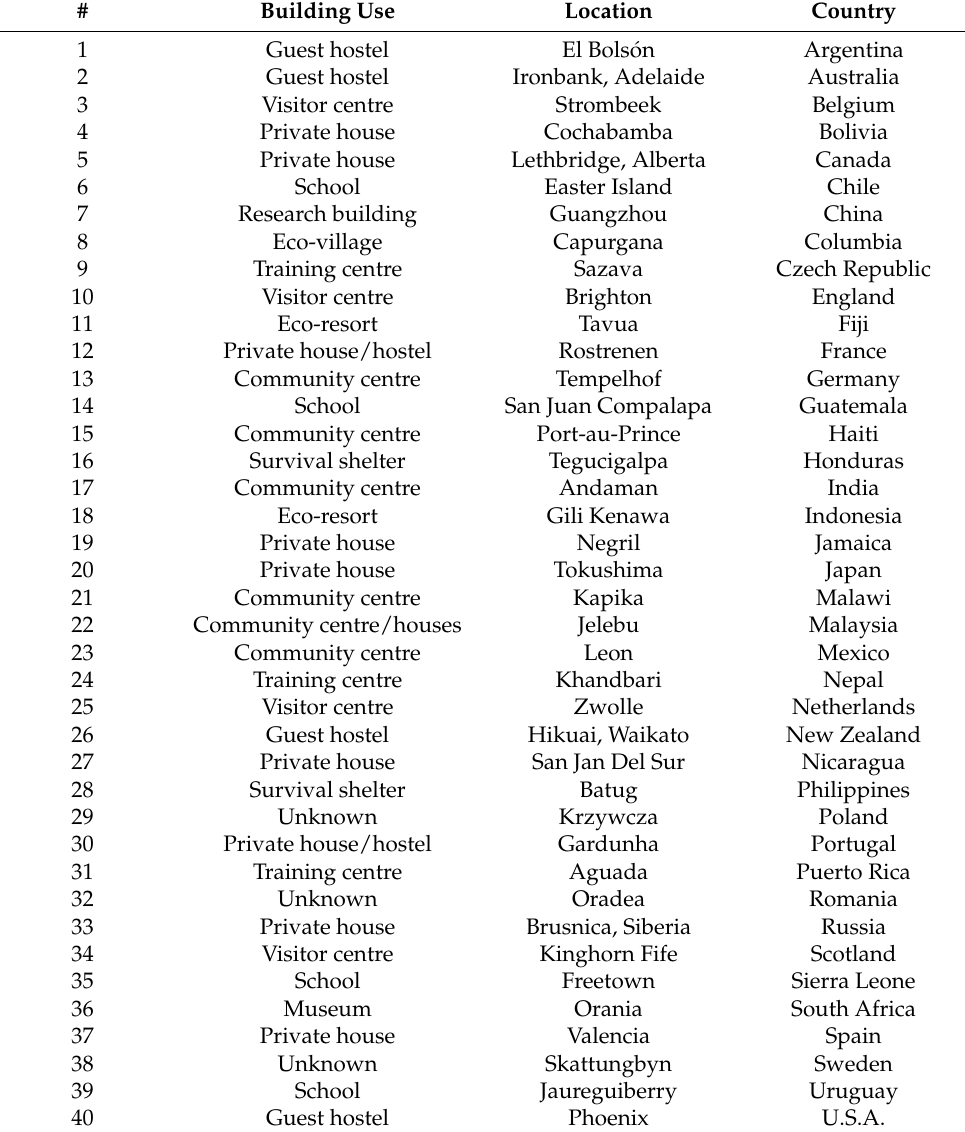
Table 1. The location and building use of some of the Earthship buildings spread across the globe (n = 40